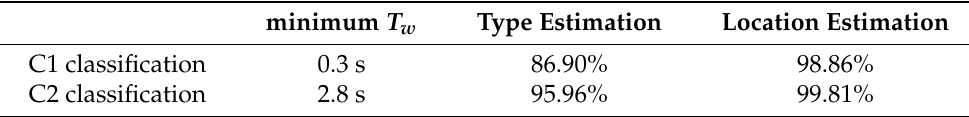
Table 1. Summary of single event decision time and